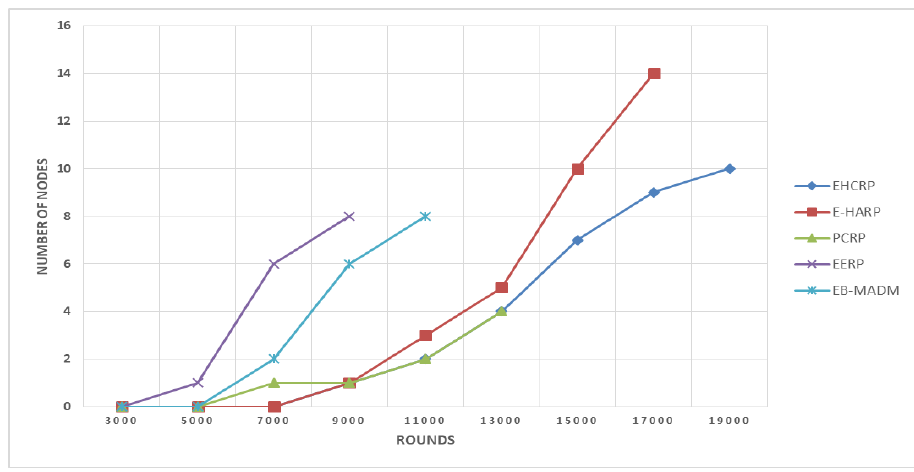
Figure 6. Breakdown of network lifetime.